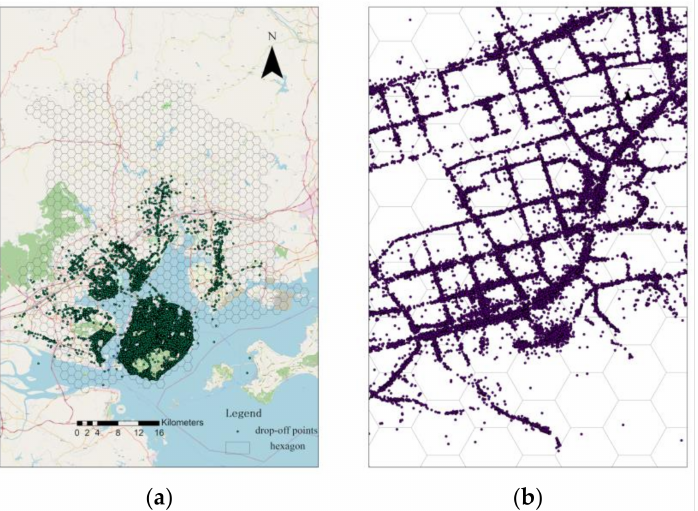
Figure 7. Using hexagons to divide the research area: ( a ) whole study area and ( b ) example area of the study area.